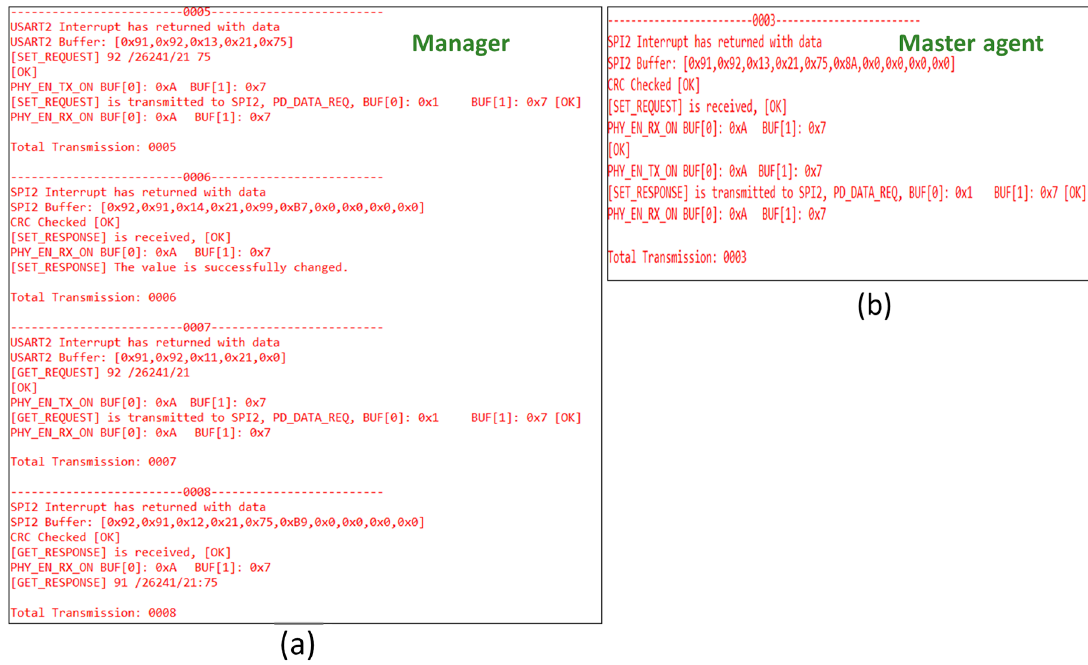
Figure 21. ( a ) Results of SET_REQUEST and SET_RESPONSE methods in the manager side of U-NMS. ( b ) Results of SET_REQUEST and SET_RESPONSE methods in the master agent side of U-NMS.